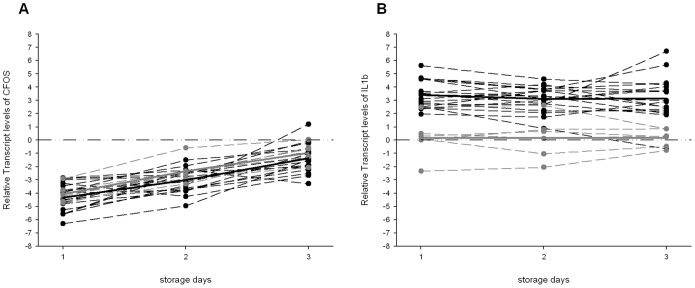
Relative Transcript levels of FOS and IL1B in individual and pools samples.Overall distribution of FOS (A) and IL1B (B) according to time storage. Each dot represents the expression levels of each individual (black) or pool (gray) samples for each time; the dashed lines indicate the time-trend for each sample. The continuous lines indicate the overall trend for individual (black) and pool (gray) samples. The horizontal dot-dashed line indicates the expected value of T0.